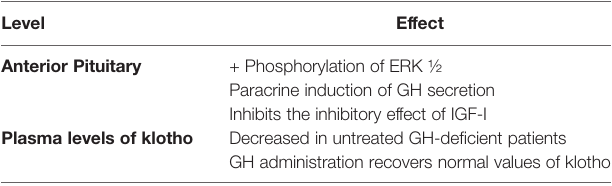
TABLE 3 | Effects of klotho on GH secretion and vice versa